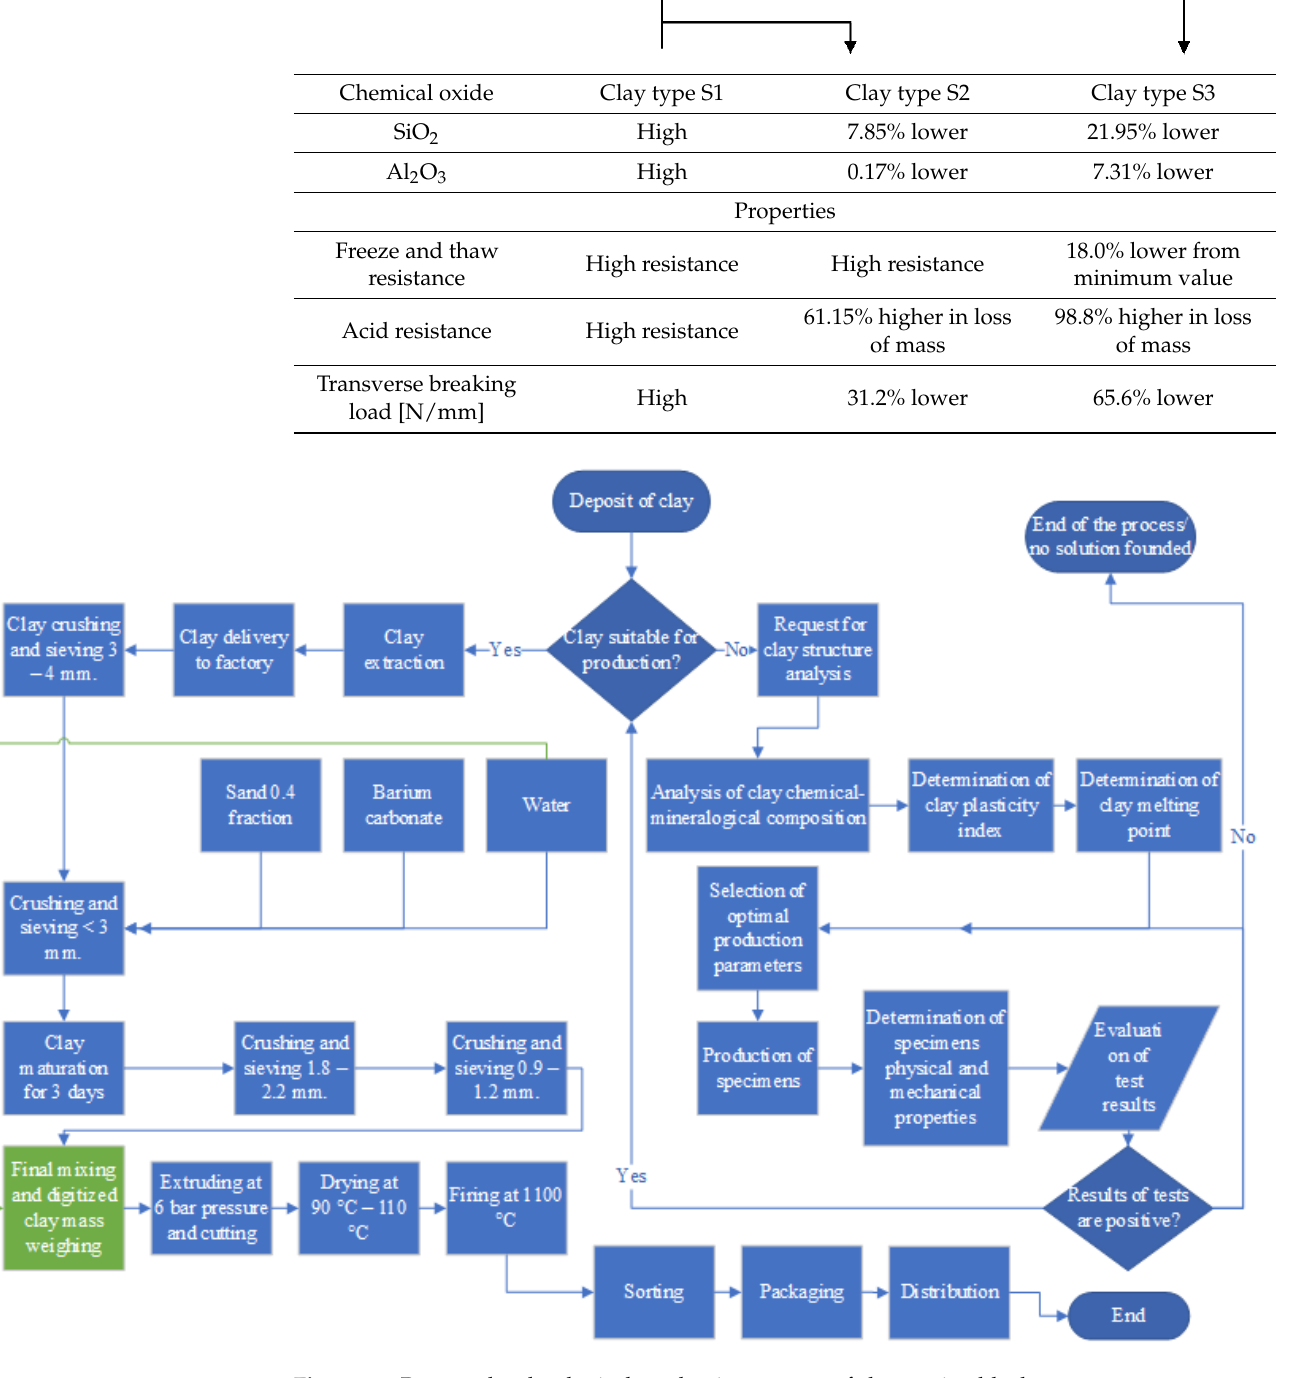
Figure 11. Proposed technological production process of clay paving